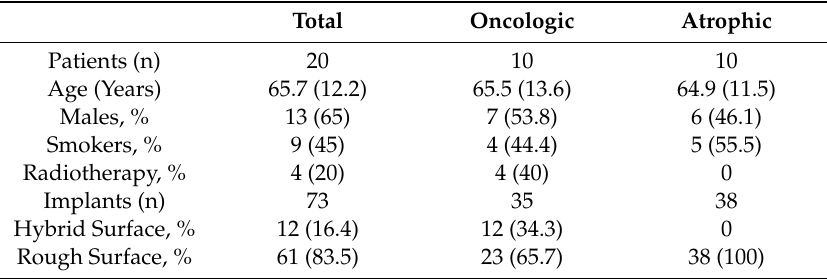
Table 1. Patient